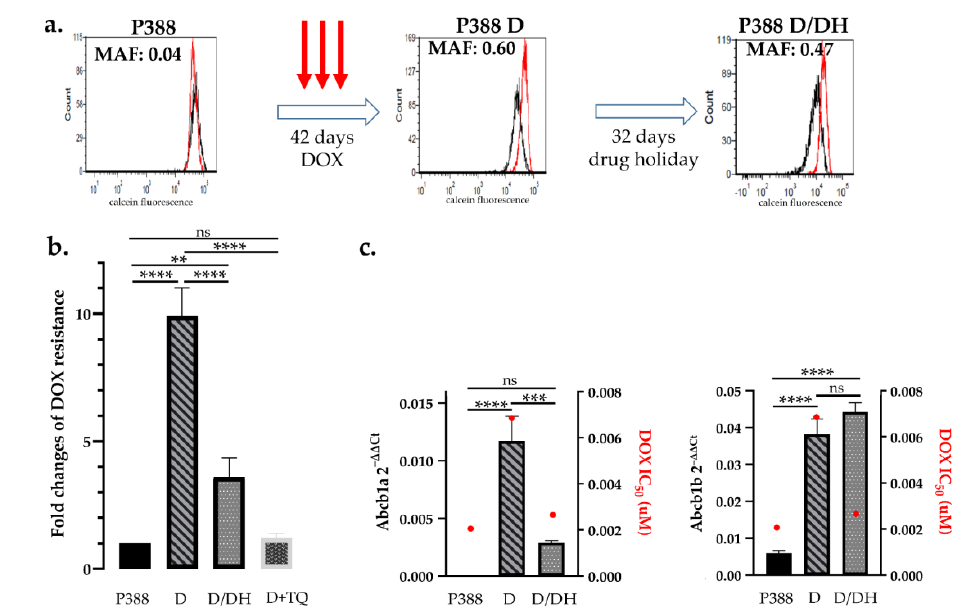
Figure 2. Effect of doxorubicin treatment and drug holiday on mouse P388 lymphoblastic